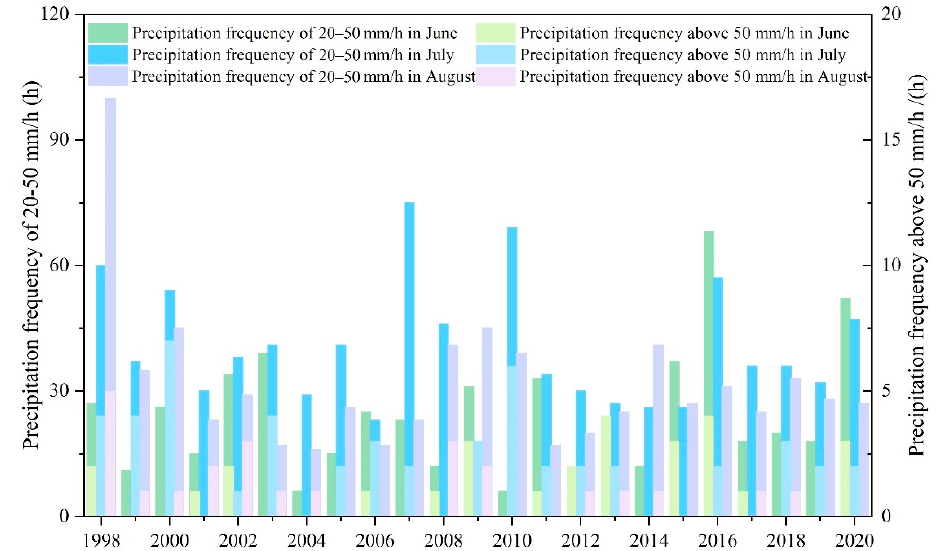
Figure 4. Statistical graph of cumulative precipitation frequency of 20–50 mm/h and above 50 mm/h from June to August, 1998–2020.